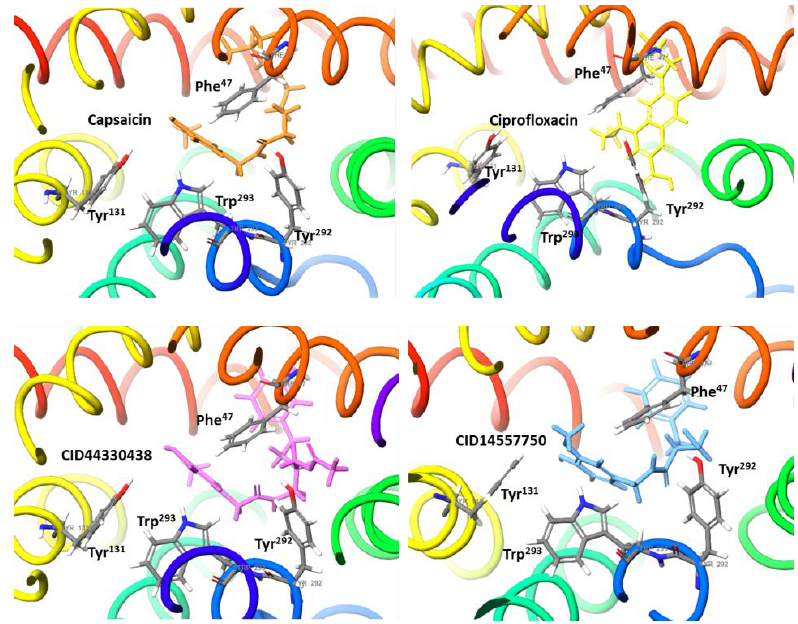
Figure 3. Binding poses of capsaicin (orange), ciprofloxacin (yellow), CID 44330438 (pink), and CID14557750 (blue) within the hydrophobic core (residues in grey) of the NorA efflux pump.